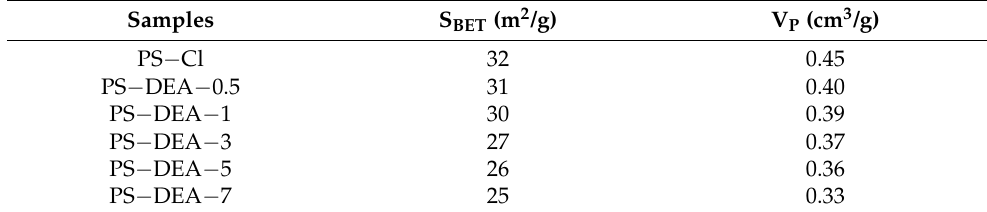
Table 2. Specific surface area and total pore volume of PS − DEA −